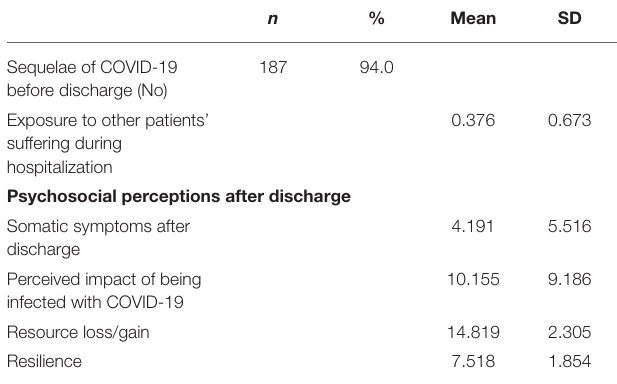
TABLE 1 | Background characteristics, physical status and psychosocial status of the participants ( n =